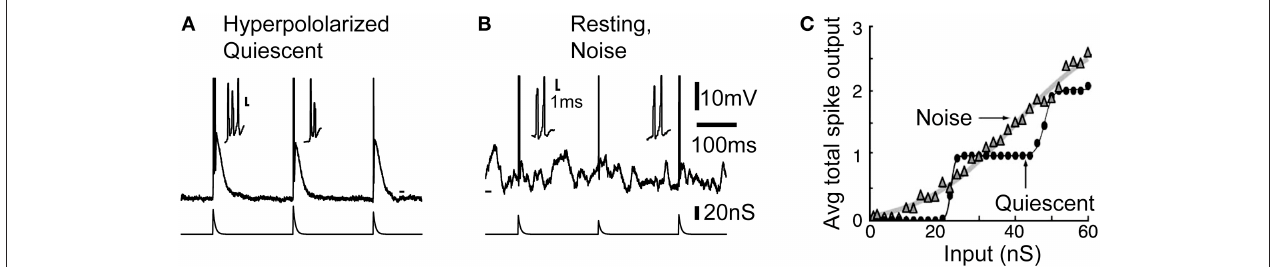
FIGURE 2 | Noise linearizes the transfer function of thalamocortical neurons through increased burstiness. (A) Typical burst response in the quiescent hyperpolarized state. (B) Bursts also occurs in response to inputs when the neuron is depolarized by background synaptic noise. (C) During resting condition, plotting the average total number of spikes per burst response against the input shows that noise linearized the staircase-like transfer function across the whole input range. Modified from Wolfart et al. (2005).